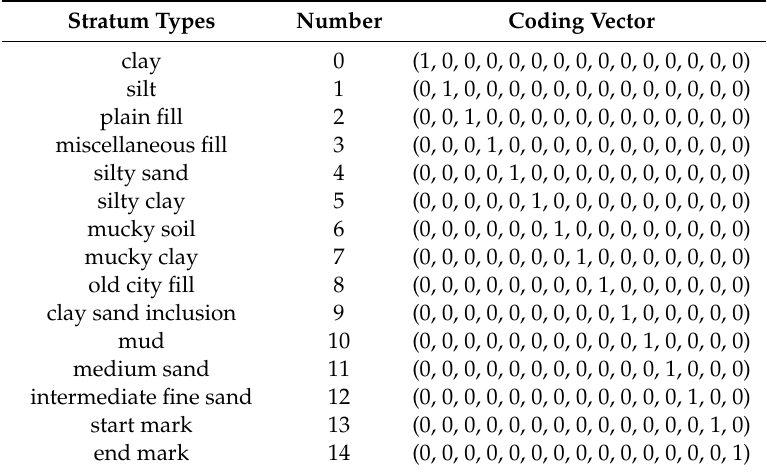
Table 1. Strata numbers and one-hot vectors.